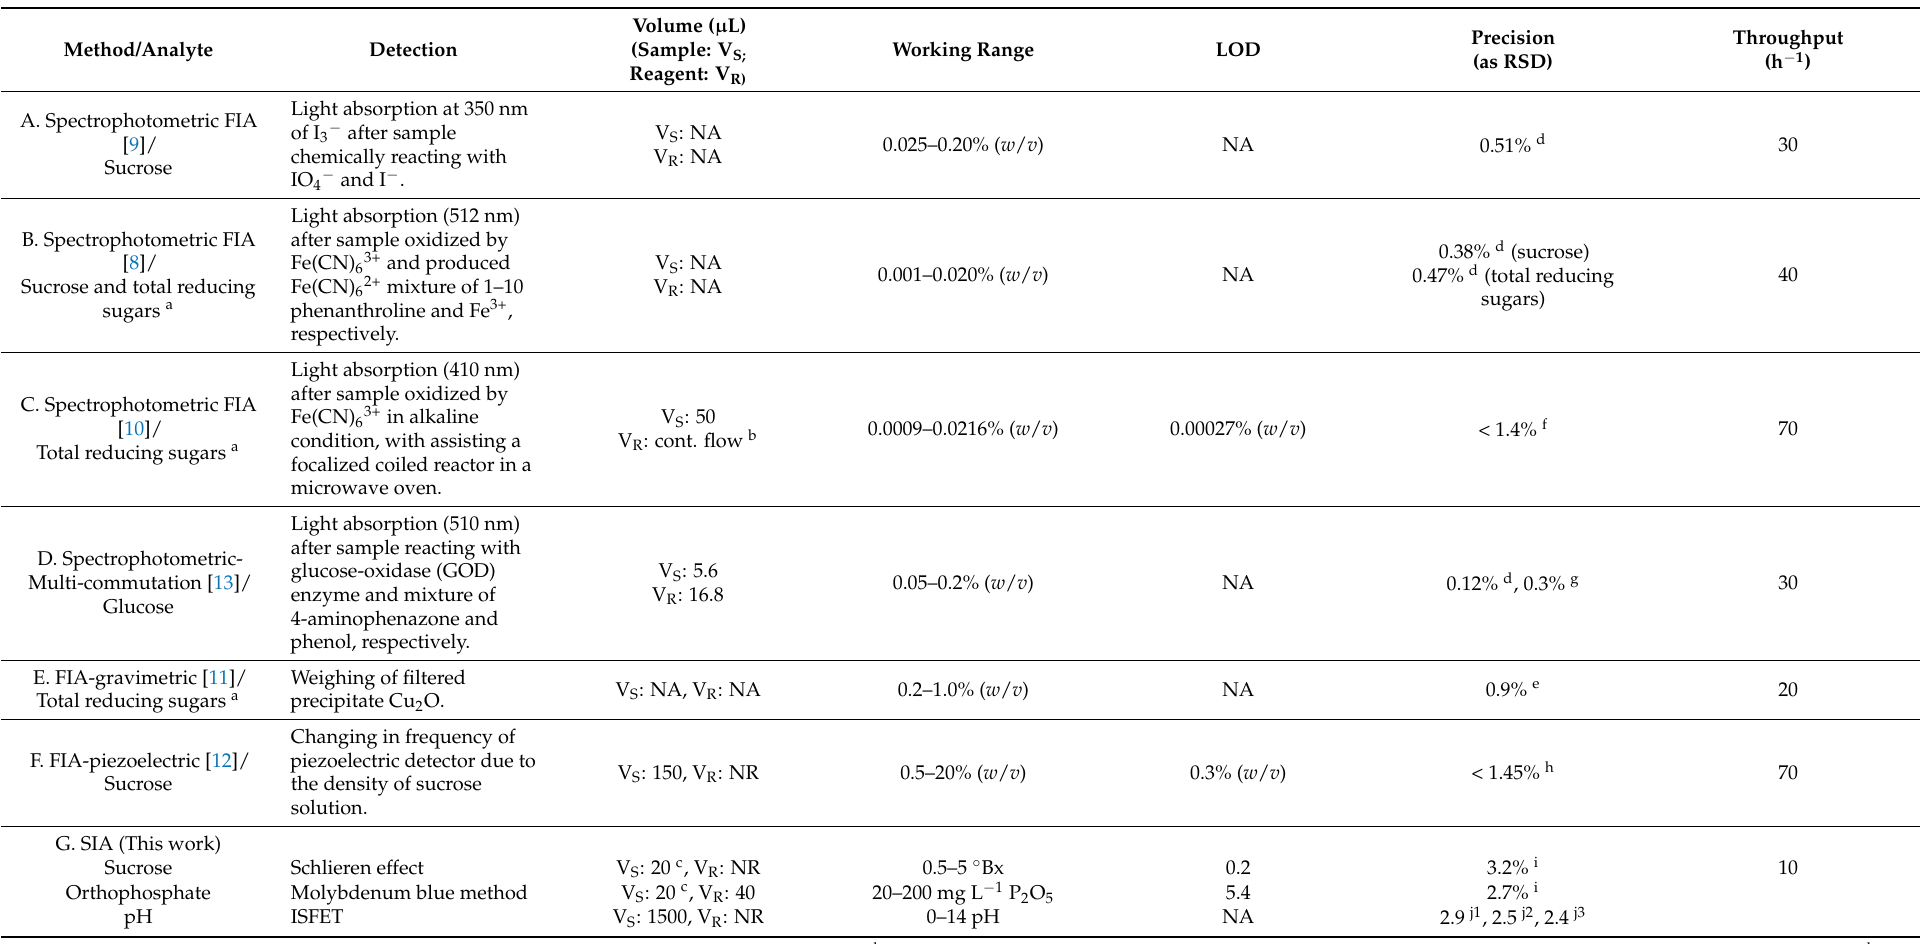
Table 5. Comparison of reported analytical flow-based methods for analysis of ◦ Bx in sugarcane